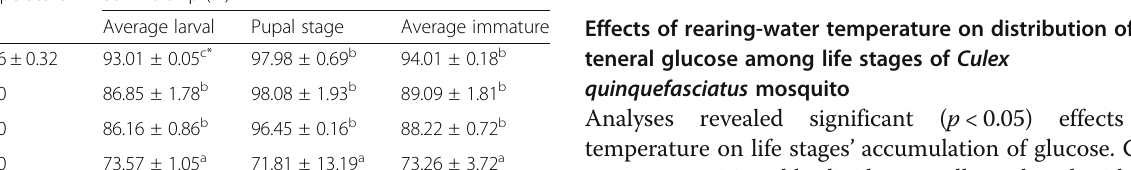
Table 2 Effects of rearing-water temperature on survivorship of immature Culex quinquefasciatus mosquito Temperature